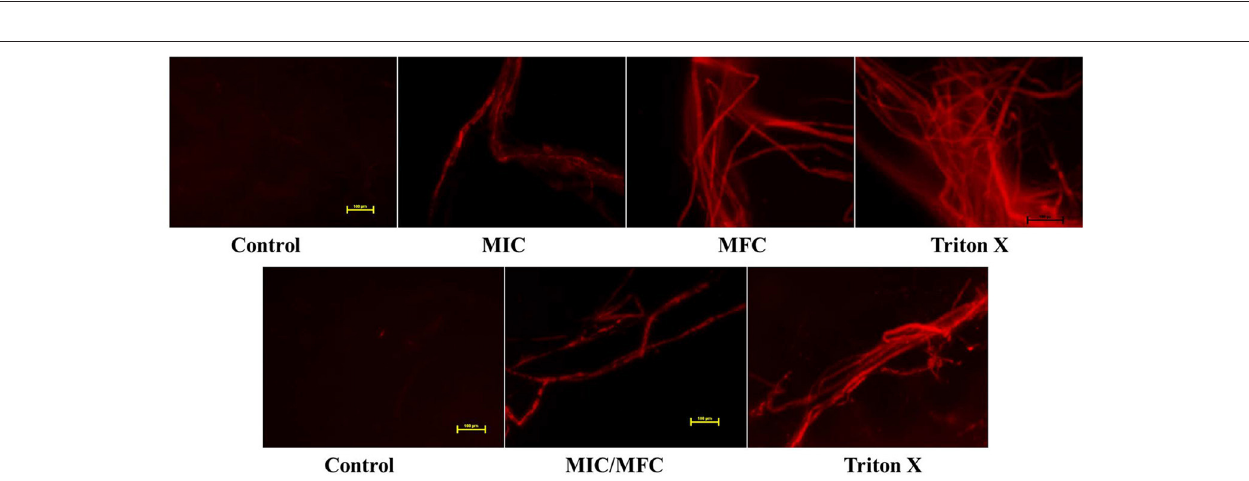
FIGURE 5 | PI uptake assay to investigate membrane disruption by chlorhexidine. The first row is of S. australis treated with 0, MIC and MFC of CHG and Triton-X 100. The second row is of S. parasitica treated with 0, MIC/MFC of CHG and Triton-X 100. Scale-100 µ m.